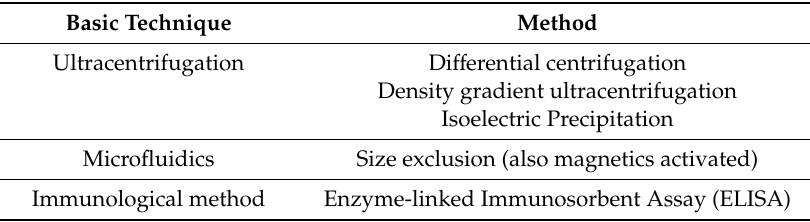
Table 1. Types of isolation technique used for milk exosomes